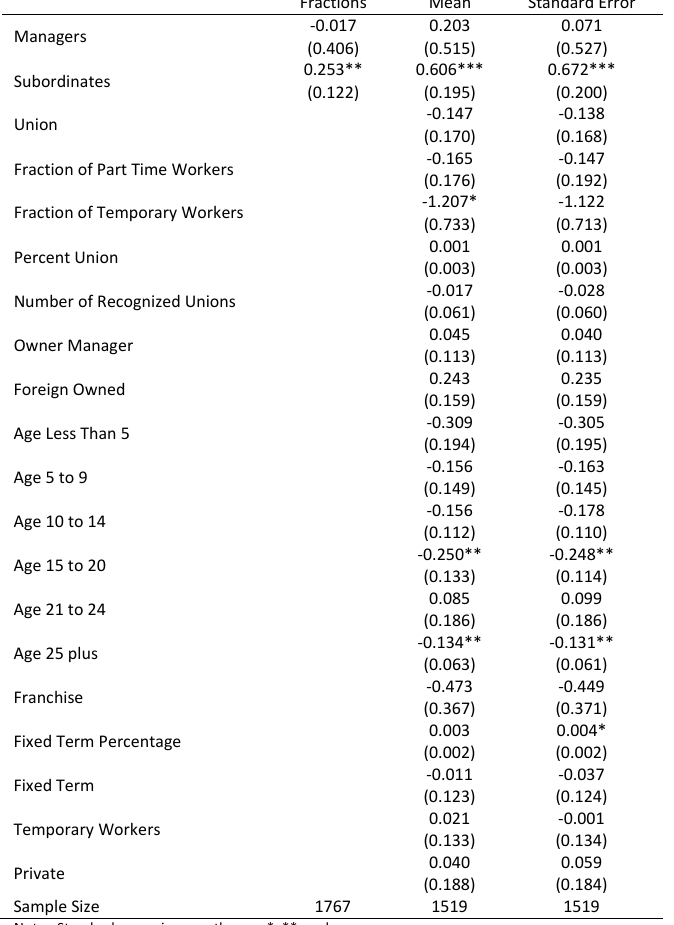
Table 3: Ordered probit models (dependent variable = financial performance)